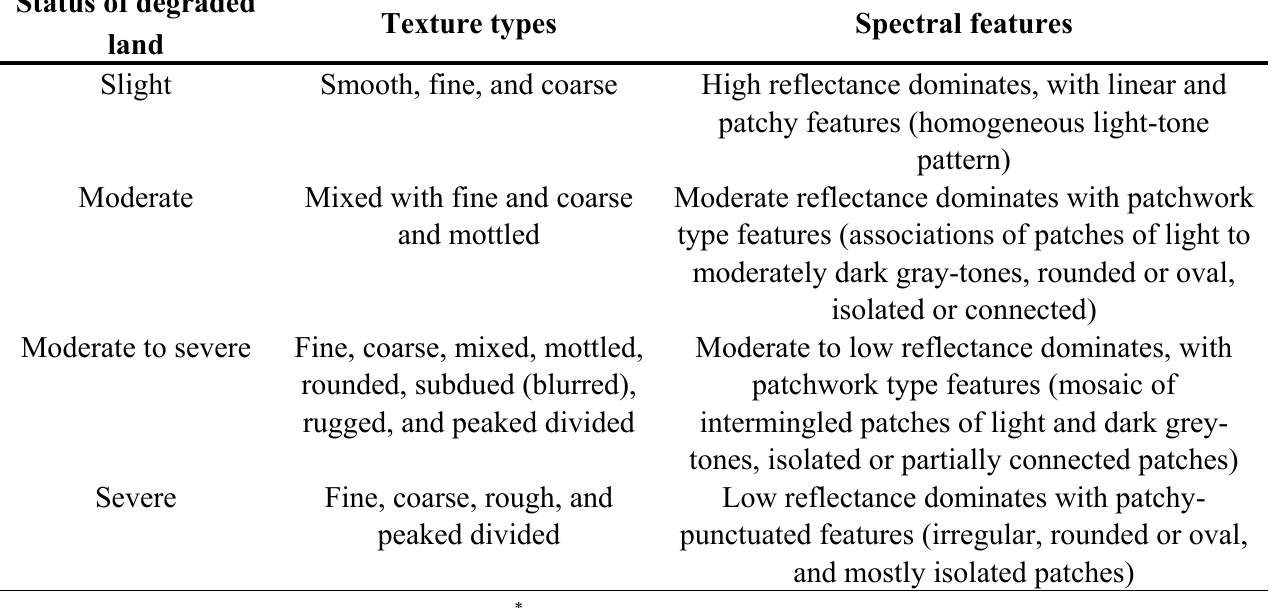
Table 1. Classification of land degradation identified